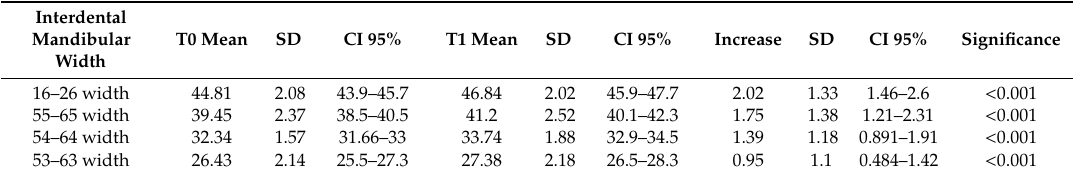
Table 5. Paired t -test comparing the mean interdental mandibular width (mm) increase after RME treatment—Control Group (n ◦ 21).